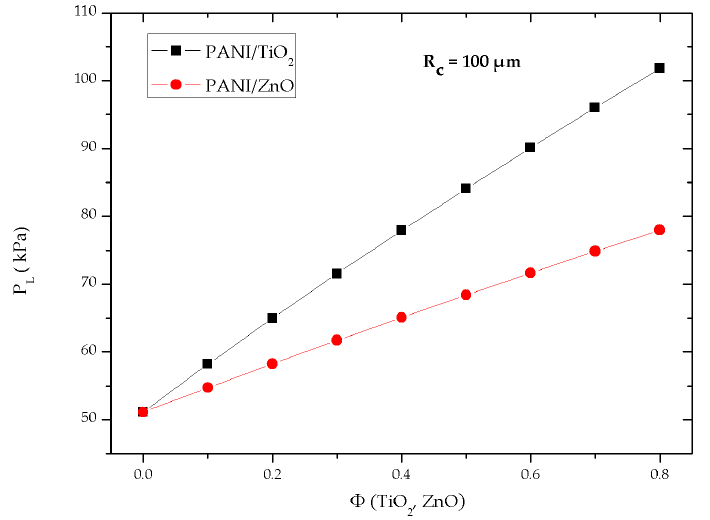
Figure 8. Laplace pressure on PANI/TiO 2 and PANI/ZnO cavity, with Rc = 1 µ m, as function of the volume fraction Φ of NPs.